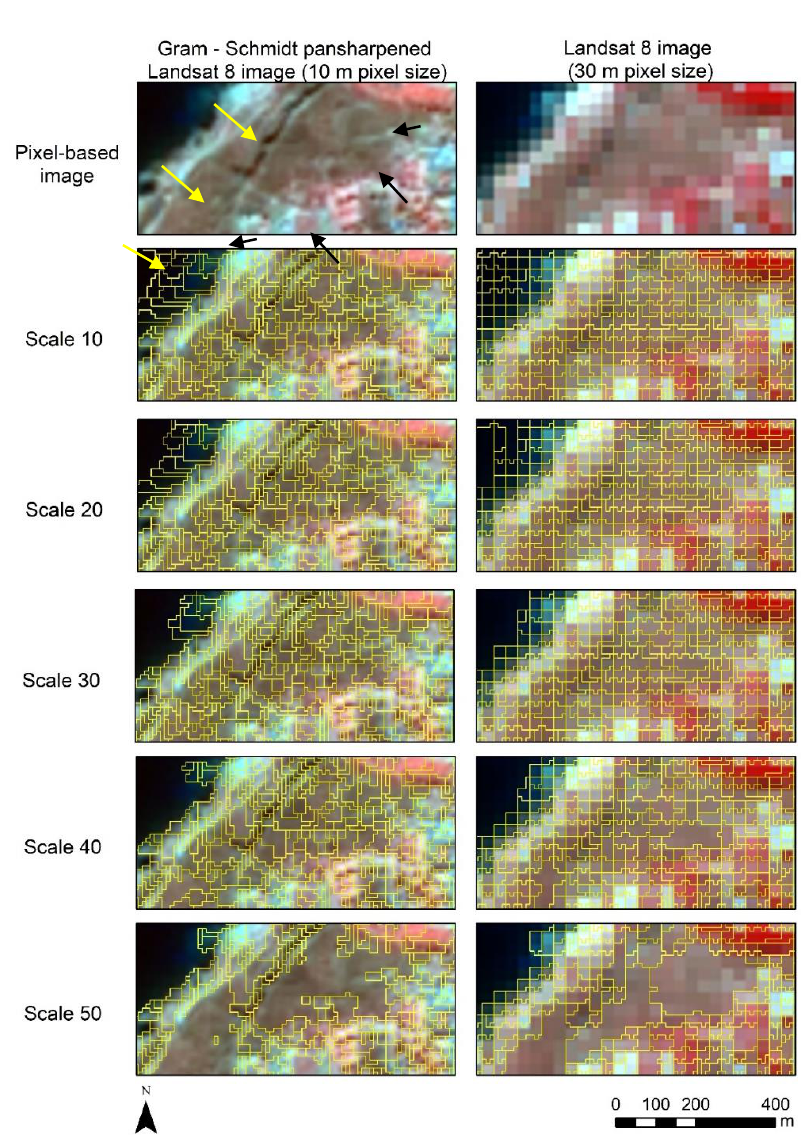
Figure 6. Segmentation results for area b of Figure 1 using a scale factor from 10 to 50, with a step of 10, applied to the Gram–Schmidt pansharpened Landsat 8 image (left) and the original Landsat 8 image (right). Groups of pixels (segments) are visualized in both images with a blue polygon. Similar results for scales 60 to 100 are shown in Figure 7. The standing defensive wall is indicated with yellow arrows and the archaeological proxies are indicated with black